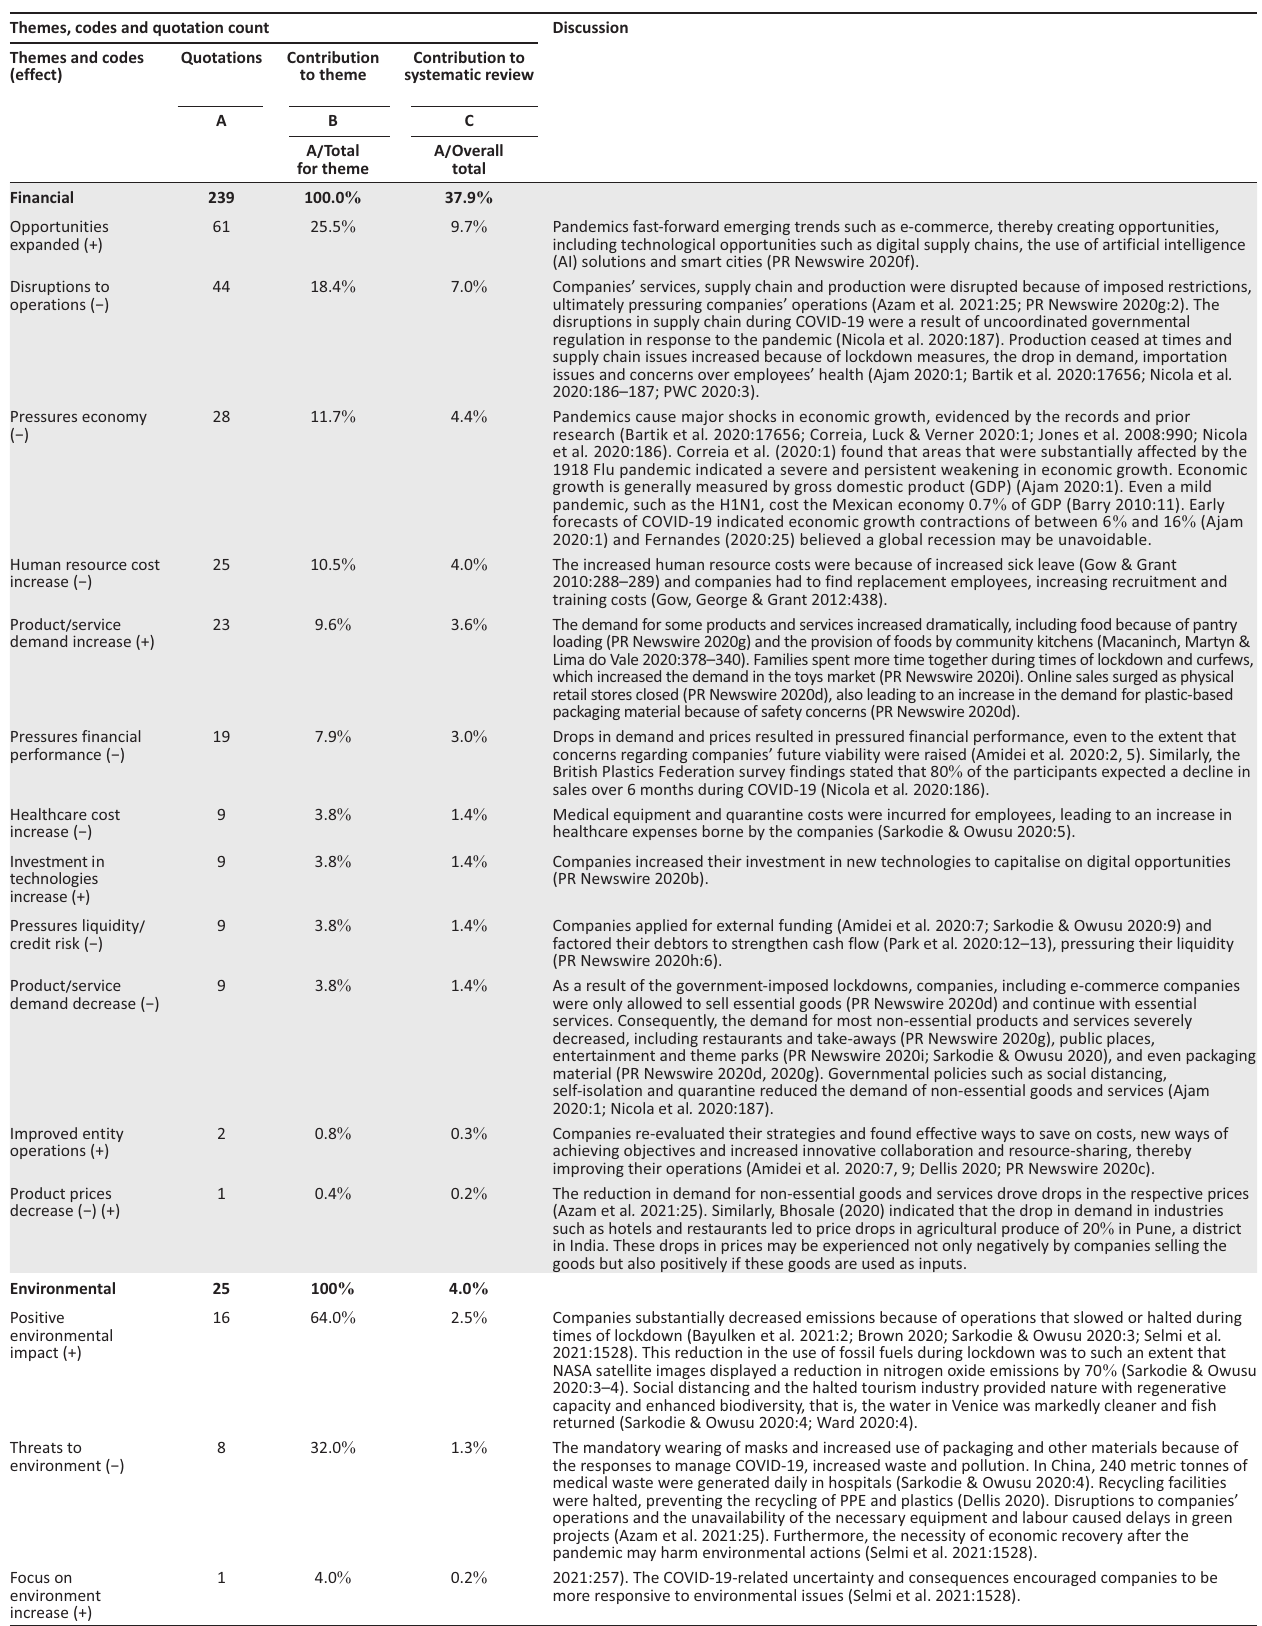
FIGURE 2: Themes, codes, quotation count and